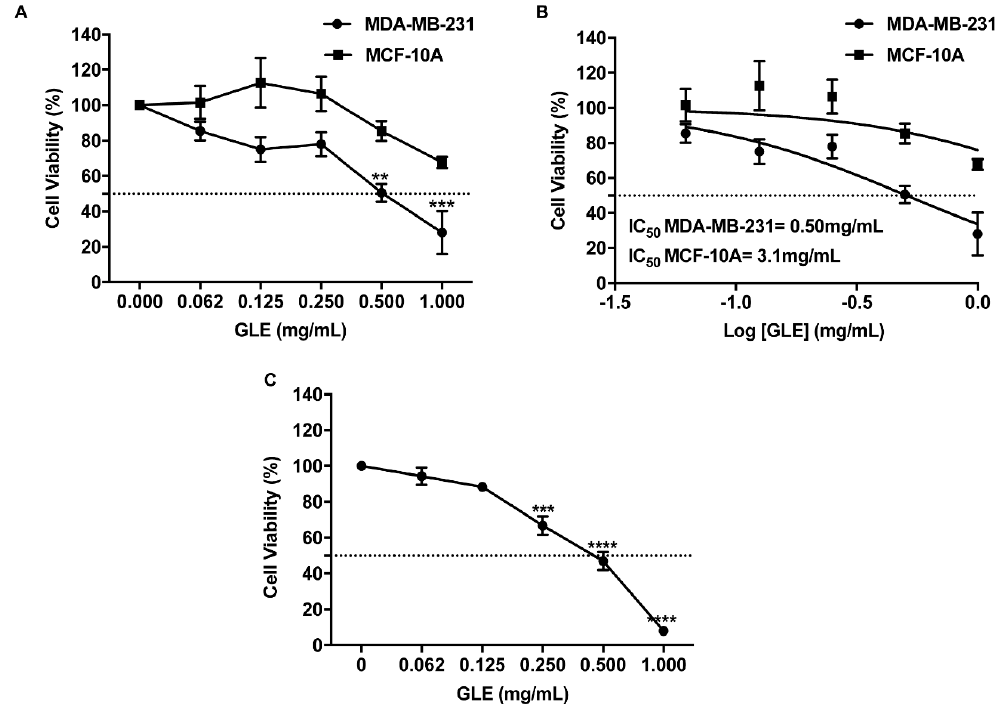
Figure 1. Ganoderma lucidum extract (GLE) decreases the viability of MDA-MB-231 breast cancer cells. ( A , B ) MDA-MB-231 (1 × 10 5 ) and MCF-10A (1 × 10 5 ) cells were treated with 0.062, 0.125, 0.250, 0.500, and 1.000 mg / mL of GLE for 48 h. Cell viability was calculated as described in materials and methods. IC 50 was calculated from dose response curve fittings using nonlinear regression parameters. ( C ) MDA-MB-231 cells were treated with same concentrations of GLE as in (A) for 48 h. Treatment was removed after 48 h and the cells were incubated for an additional 72 h to assess recovery by a washout assay. Data are expressed as mean ± SEM. Experiments represent data obtained from three independent biological replicates. Statistically significant di ff erences are shown at ** p < 0.01, *** p < 0.001, **** p < 0.0001 compared to vehicle.